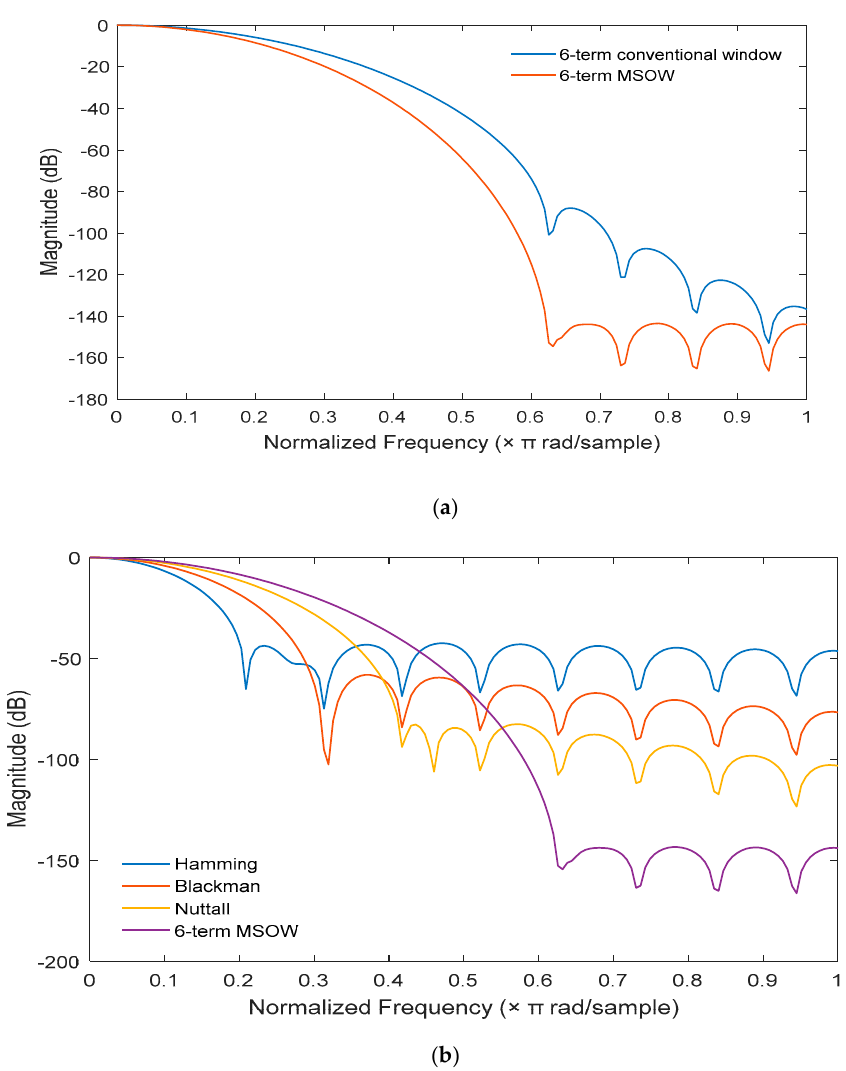
Figure 2. Comparison of the spectrum characteristics between windows. ( a ) Comparison between the six-term MSOW and the six-term conventional window and ( b ) comparison between the six-term MSOW and the existing conventional windows.